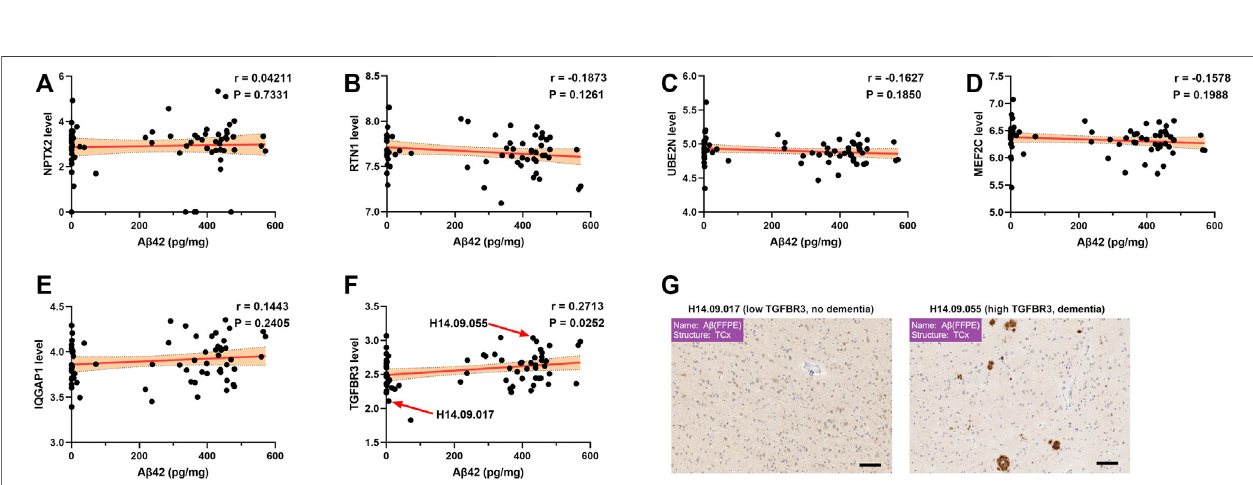
FIGURE4| HighTGFBR3levelwassigni fi cantlyassociatedwithA β accumulation (A-F) Pearsoncorrelationanalysiswasusedtoevaluatetheassociationbetween A β level and gene expression levels of NPTX2 (A) , RTN1 (B) , UBE2N (C) , MEF2C (D) , IQGAP1 (E) and TGFBR3 (F) in 68 brain temporal cortex tissues from the Allen Brain Atlas (G ) Representative immunohistochemistry staining data for A β . Scale bars, 100 μ m.